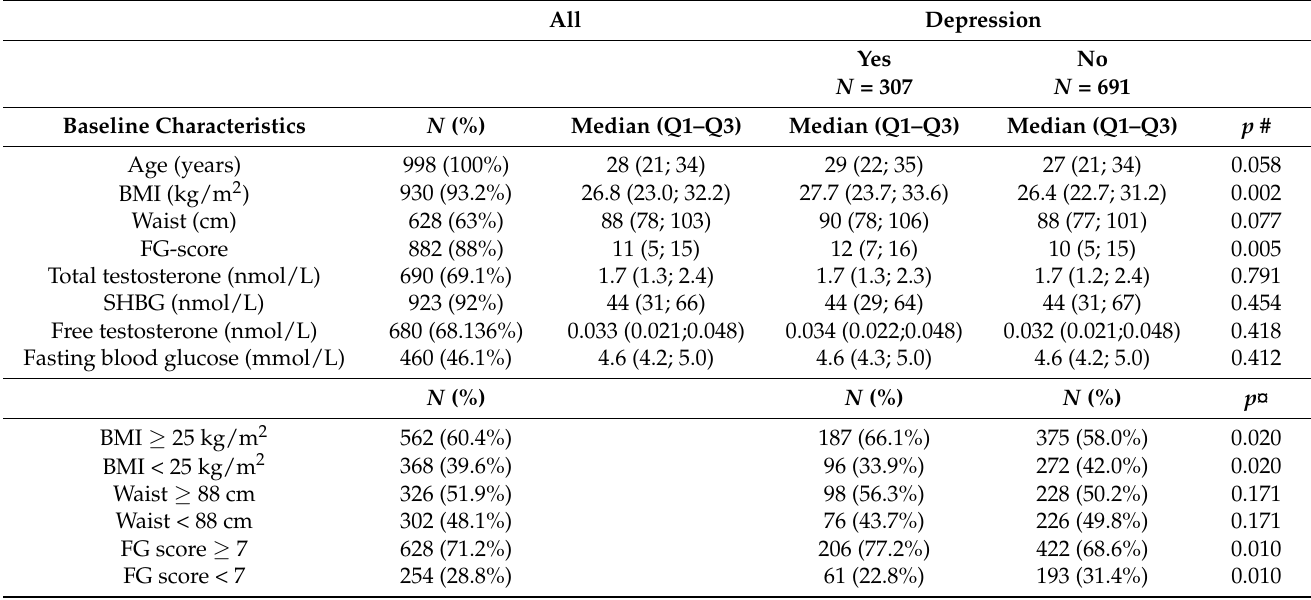
Table 5. Baseline clinical and biochemical characteristics according to development of depression in PCOS OUH ( N = 998).